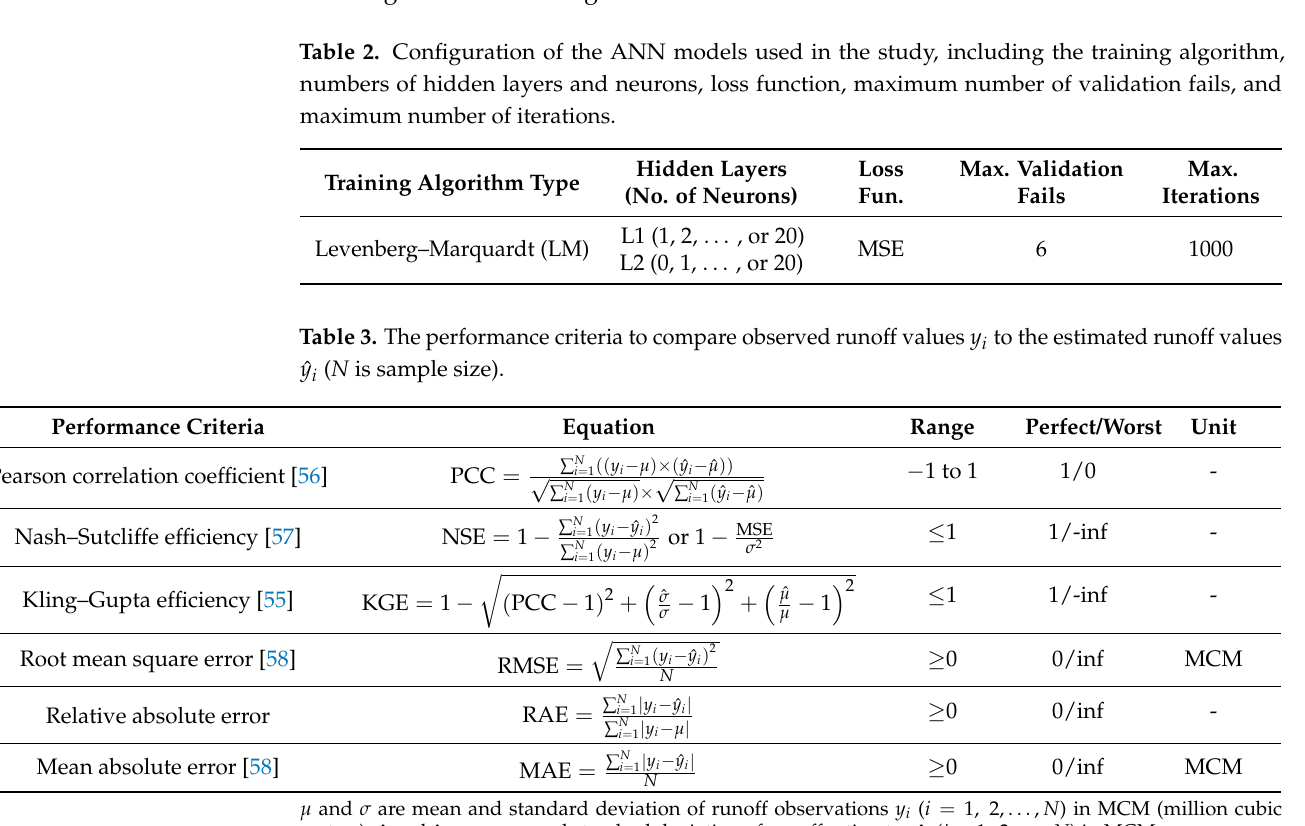
Hidden Layers Loss Max. Validation Max. (No. of Neurons) Fun. Fails Iterations